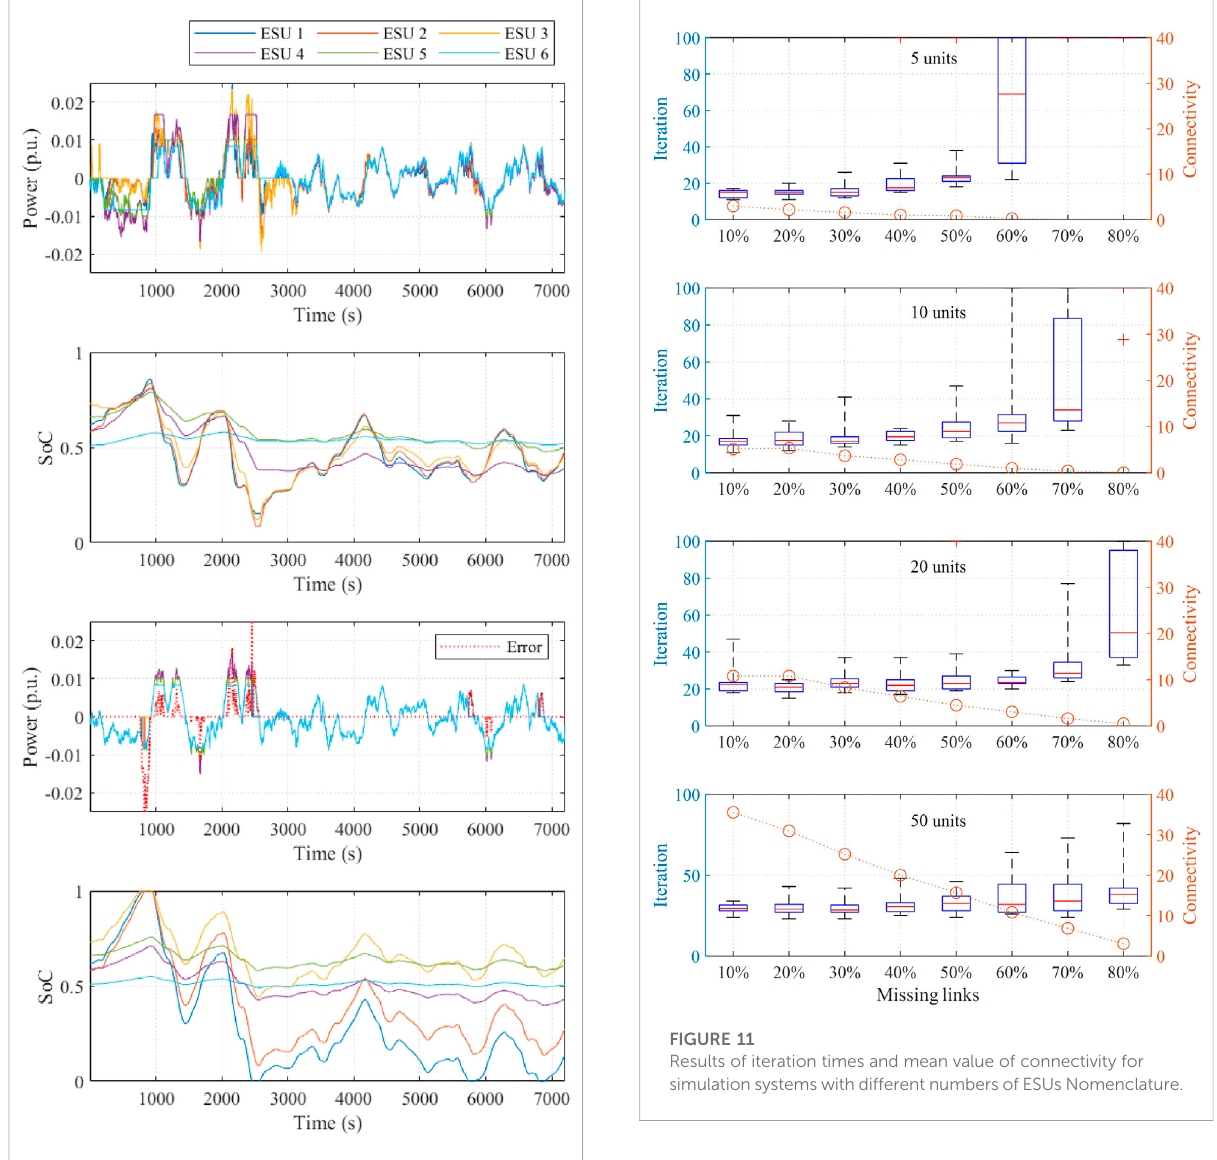
FIGURE 10 Power output and SoC level of each ESU compared under (A,B) DA control and (C,D) equally allocation